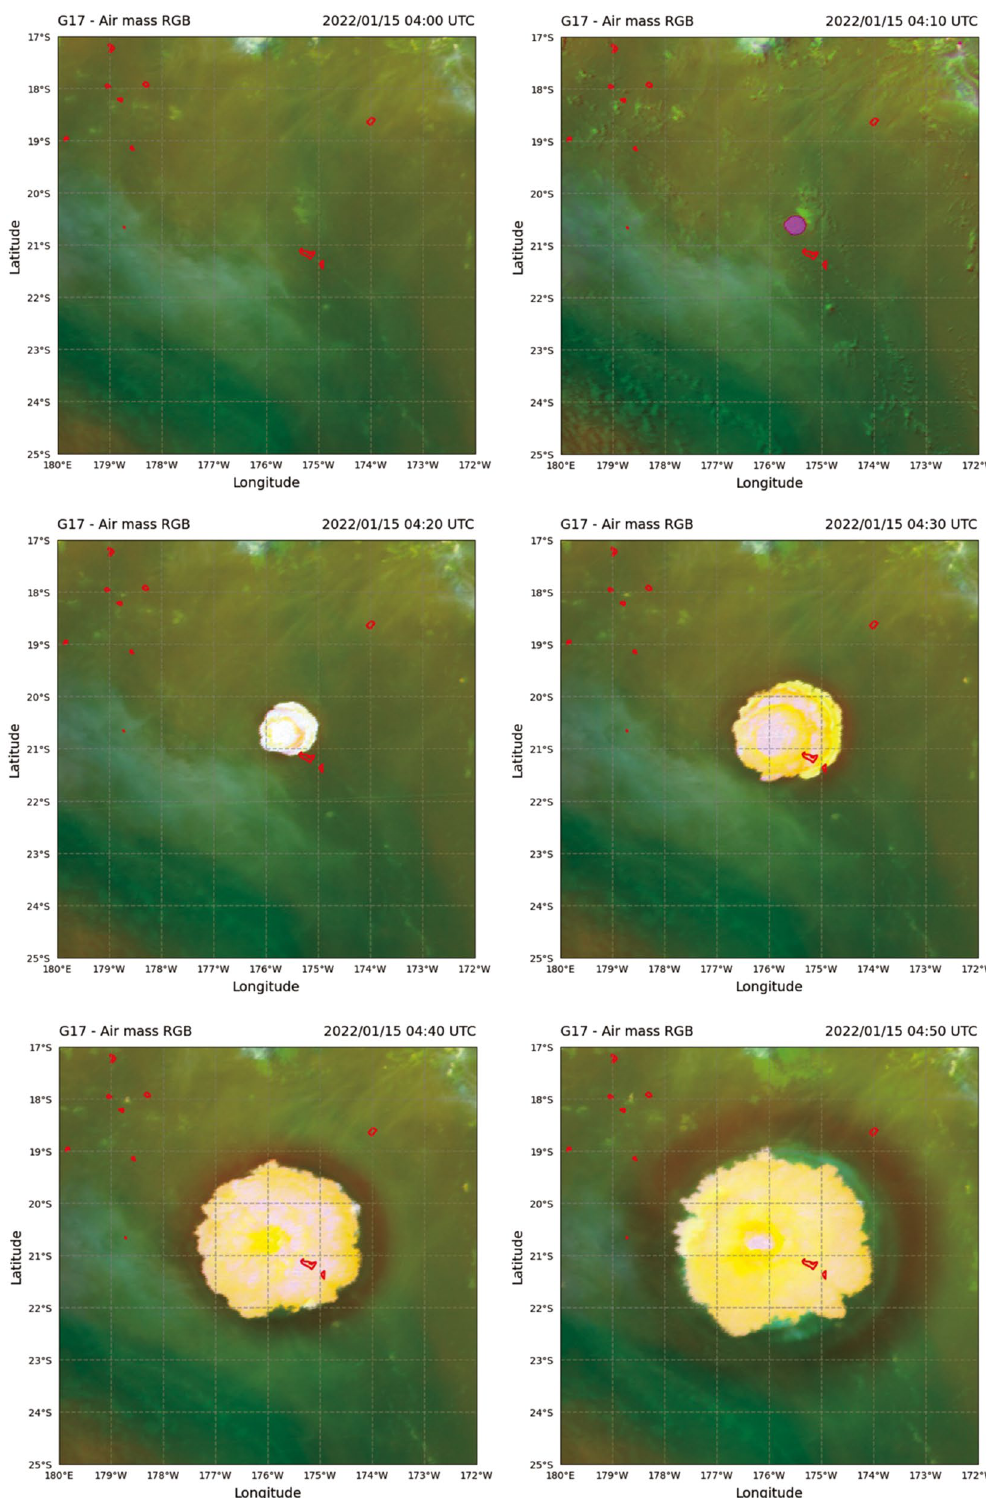
Fig. 13 Air mass RGB using GOES-17 from 04:00 to 04:50 on 15 January